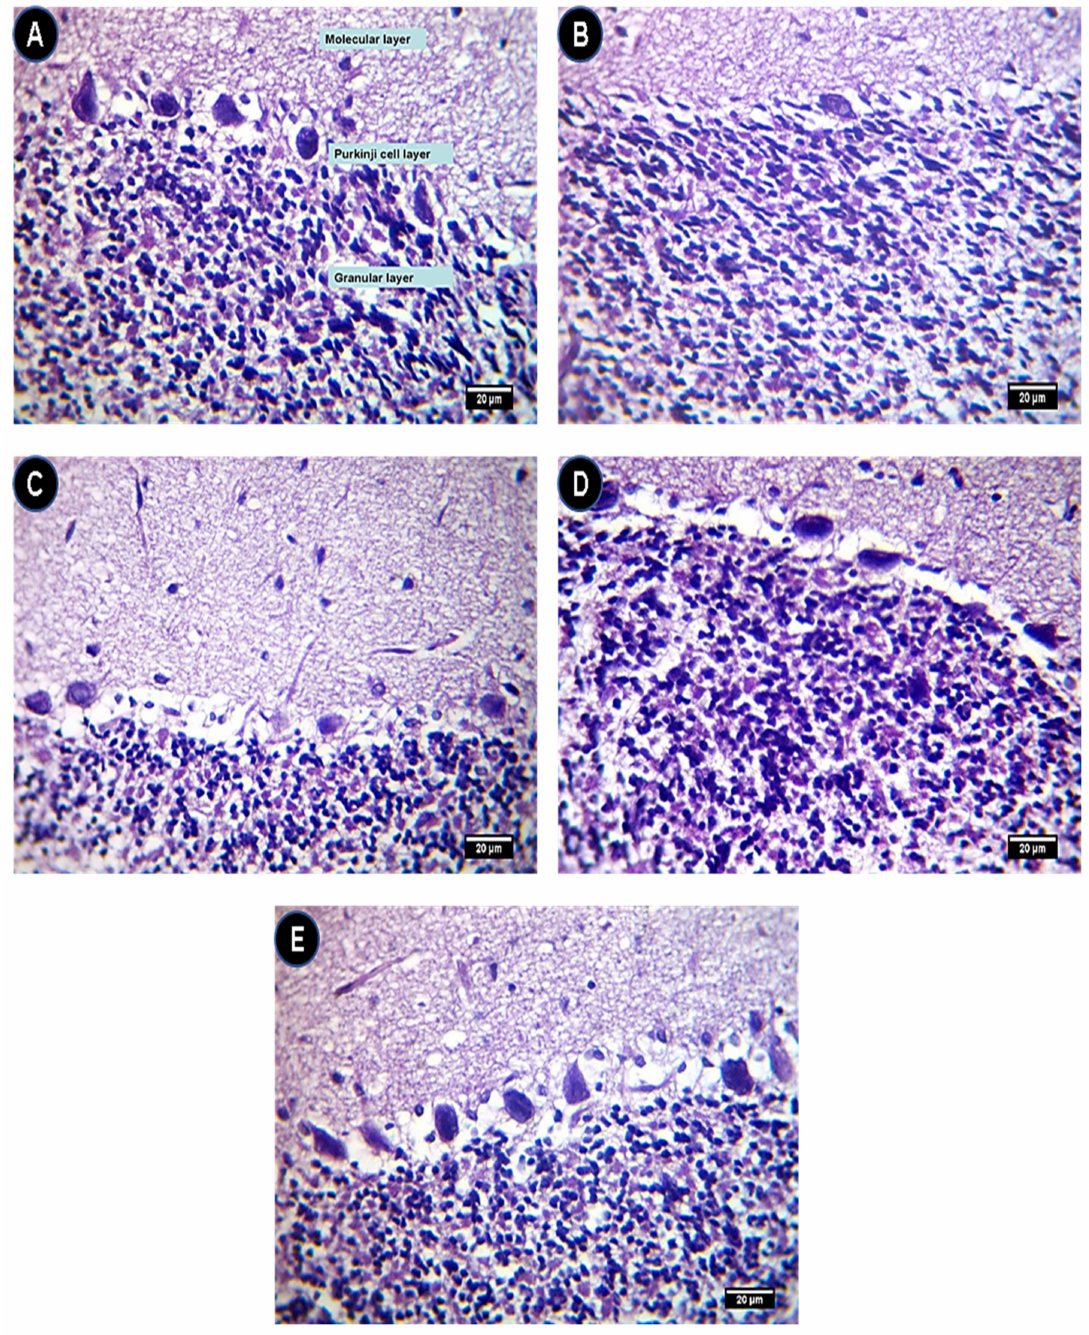
Figure 6. Cerebellum histopathology. ( A ) Control group showing a normal histological structure of cerebellum layers. ( B ) IONP group showing a severe depletion of the Purkinje cells. ( C ) IONPs + Q25 group showing a moderate depletion of the Purkinje cells. ( D ) IONPs + Q50 group showing a moderate to mild depletion of the Purkinje cells. ( E ) IONPs + Q100 group showing a mild depletion of the Purkinje cells. Hematoxylin (H) and eosinH and (E) ( × 400). Scale bar = 20 µ